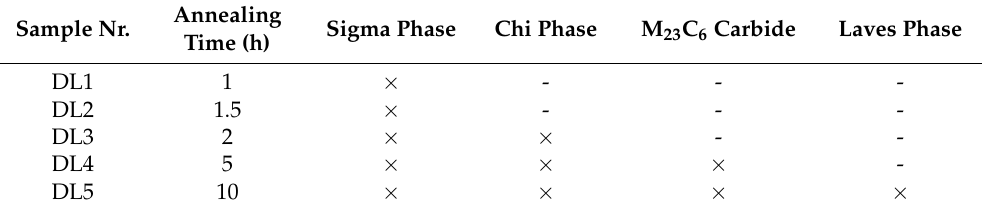
Figure 6. TEM analysis results of carbon extraction replicas of AISI 316L (40% CW): ( a ) 650 ◦ C/1 h of annealing; ( b ) 650 ◦ C/10 h. Table 4. Experimentally identified secondary phases in the investigated AISI 316L steel (40% CW) with subsequent annealing at 650 ◦